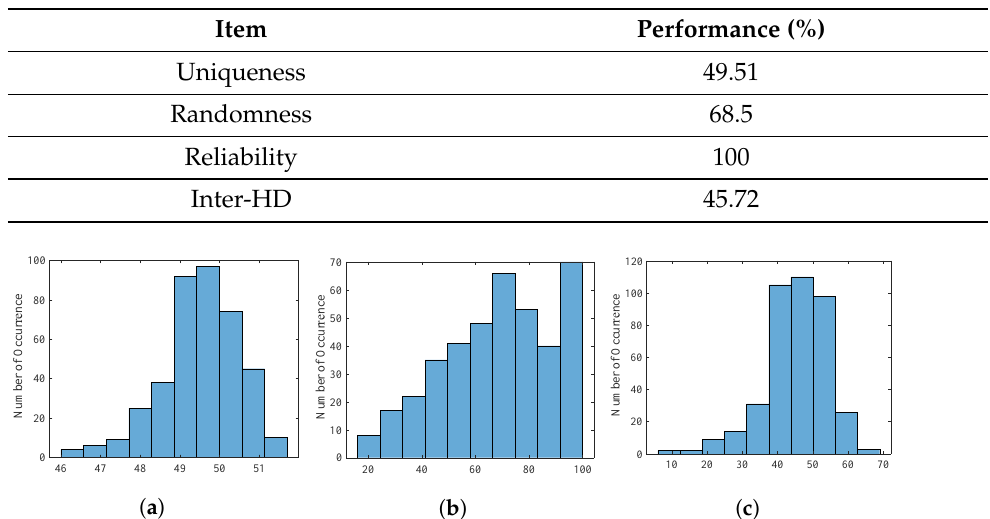
Table 4. Characteristics of the PUF.